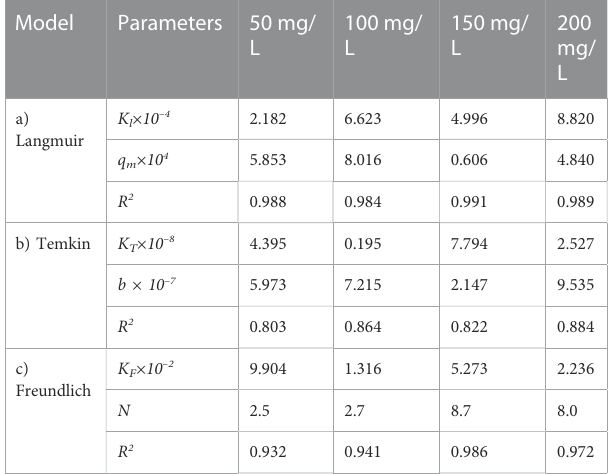
TABLE 14 Parameters of a) Langmuir, b) Temkin, and c) Freundlich isotherm models at different adsorbent amount using Oil sludge 3 as carbon active at T = 318 K and pH =